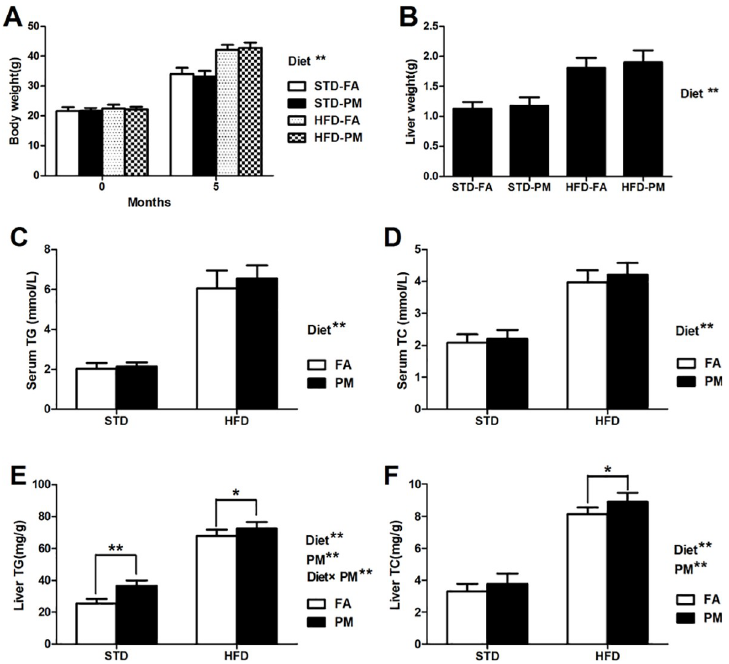
Fig 2. The body weight, liver weight, serum and hepatic lipid levels (n = 10). (A) Body weight. (B) Liver weight. (C) Serum TG levels. (D) Serum TC levels. (E) TG levels in liver. (F) TC levels in liver. Data are expressed as the mean ± SD. � , P < 0.05 and �� , P < 0.01 compared with the STD-FA group. ## , P < 0.01 compared with the STD-PM group. Diet �� indicates the HFD. PM �� indicates PM exposure. � , P < 0.05 and �� , P < 0.01. Diet × PM indicates the interaction effect between HFD and PM